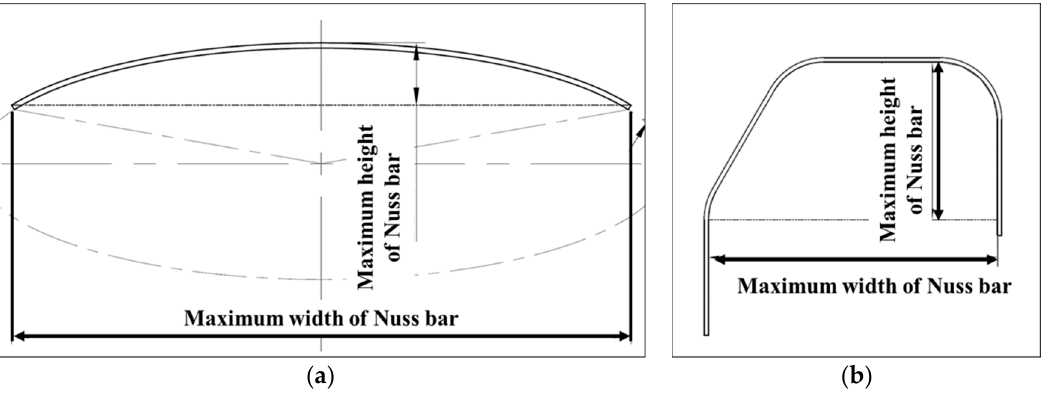
Figure 15. Designs of test sample: ( a ) central arc design with measuring point of maximum width and height; ( b ) transition Nuss bar design with measuring points.